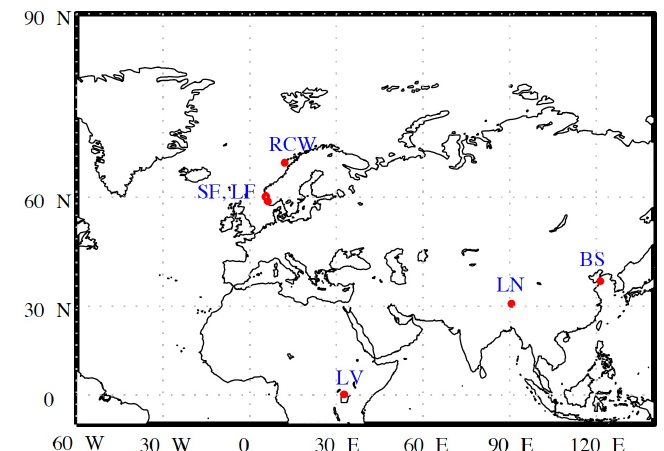
Figure 1. World map with solid red dots indicating the six study sites: LV = Lake Victoria, Uganda; LN = Lake Namtso, Tibet; BS = Bohai Sea, China; SF = Samnangerfjord, Norway, LF = Lysefjord, Norway; RCW = Røst Coastal Water,